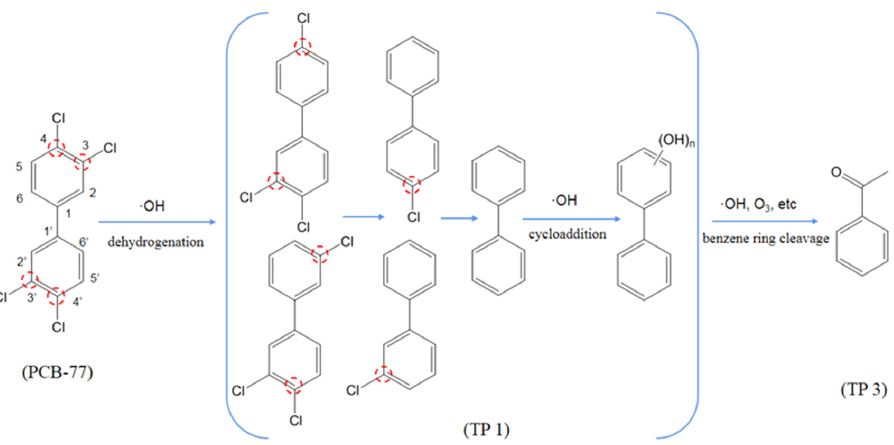
Figure 5. The proposed PCB77 degradation pathway.